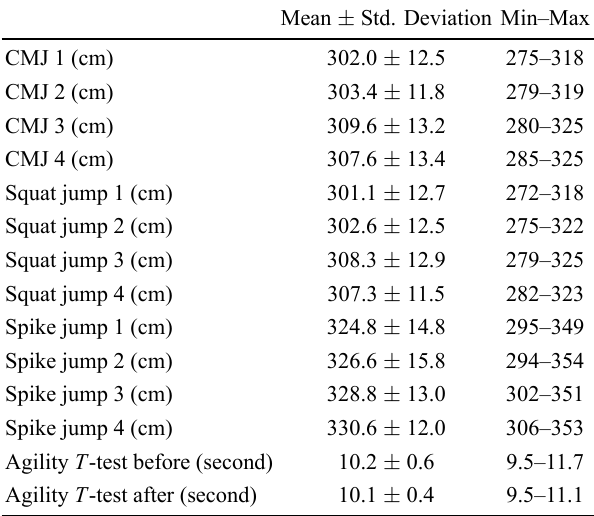
Table 2. Countermovement jump, squat jump, spike jump, and agility T -tests of the volleyball players.